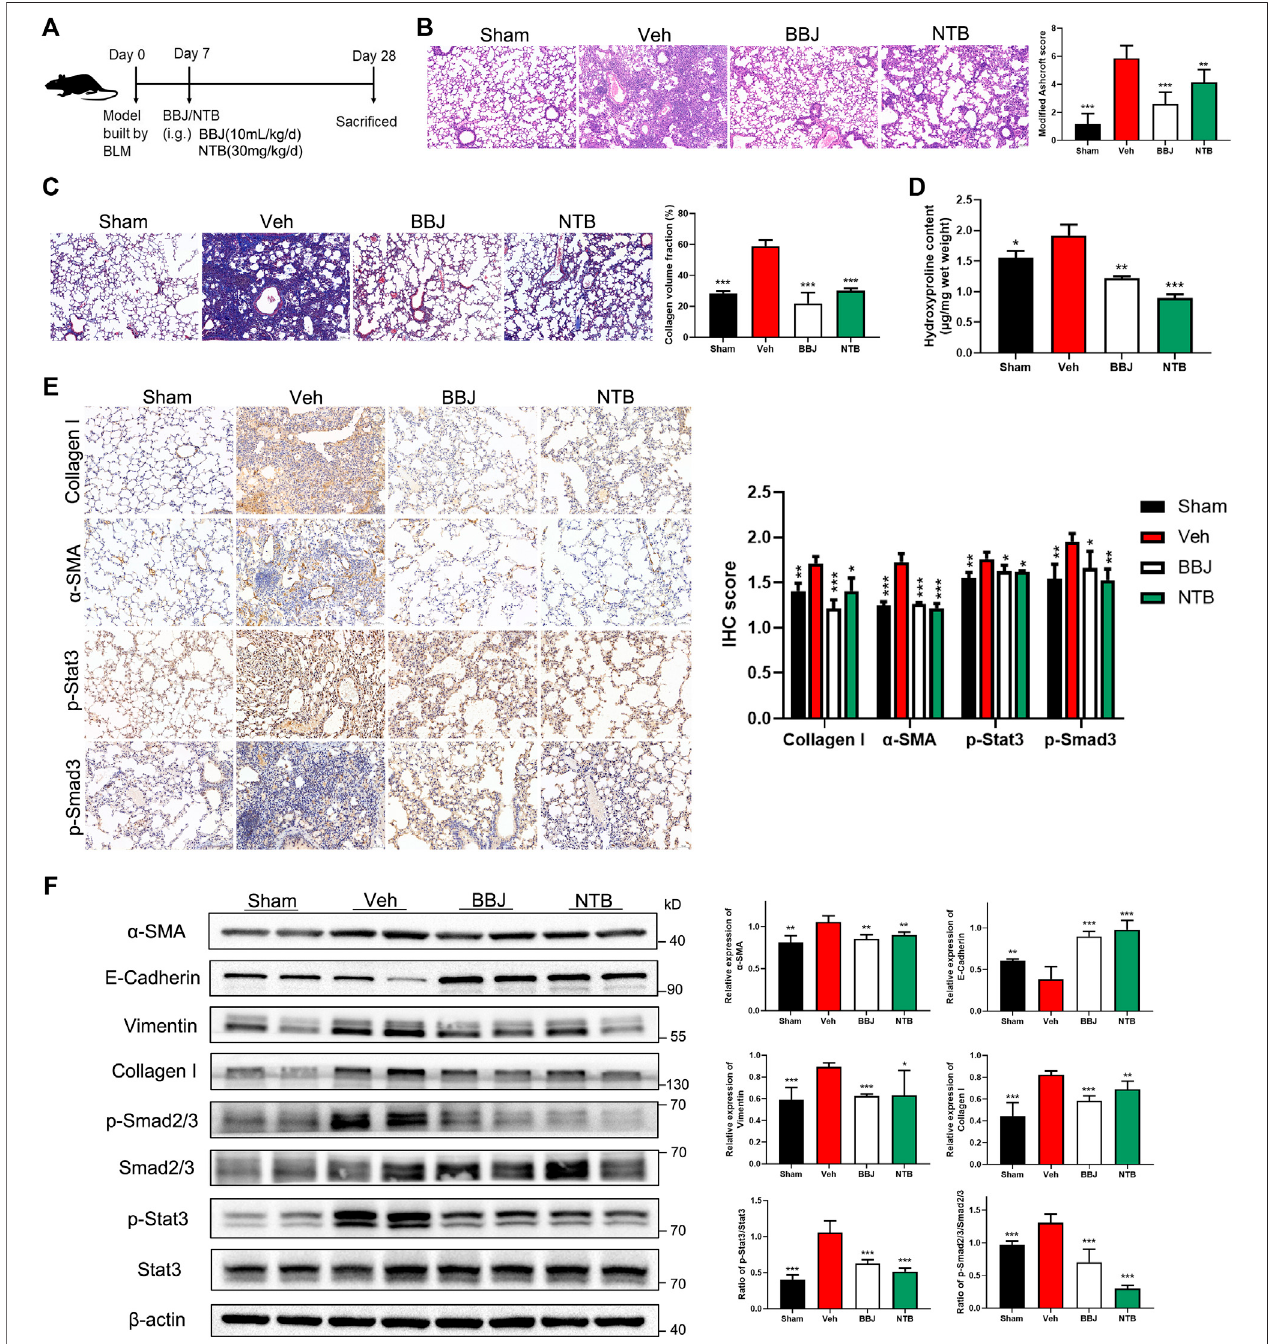
FIGURE 6 | BBJ could alleviate pulmonary fi brosis caused by BLM. (A) Arrangement of animal study in the treatment model. The fi brosis model was built by tracheal injection of BLM on day 0. On day 7, vehicle, BBJ-fed, and NTB-fed groups were administrated with saline, BBJ, and NTB for 3 weeks, respectively. (B) Lung sections of each group were stained with H&E (×10). Modi fi ed Ashcroft scores were applied to evaluate the degree of pulmonary fi brosis. (C) Lung sections of each group were stained with Masson trichrome (×10). Collagen volume fractions were analyzed from the results of Masson-stained lung sections by ImageJ. (D) Hydroxyprolinecontentsweretestedbythehydroxyprolineassaykit. (E) Theexpressionsofcollagen-I, α -SMA,p-Stat3,andp-Smad3inlungsectionsweredetectedby IHC staining, and these proteins ’ expressions were calculated by ImageJ. (F) Expressions of α -SMA, E-cadherin, vimentin, collagen-I, Smad2/3, p-Smad2/3, Stat3, p-Stat3,and β -actininlung tissues ofeach groupwereanalyzed bywesternblotting.ImageJsoftwarewasused tocalculatetheseproteins ’ expressions.*, p < 0.05;**, p < 0.01; ***, p < 0.001 compared with the vehicle group.